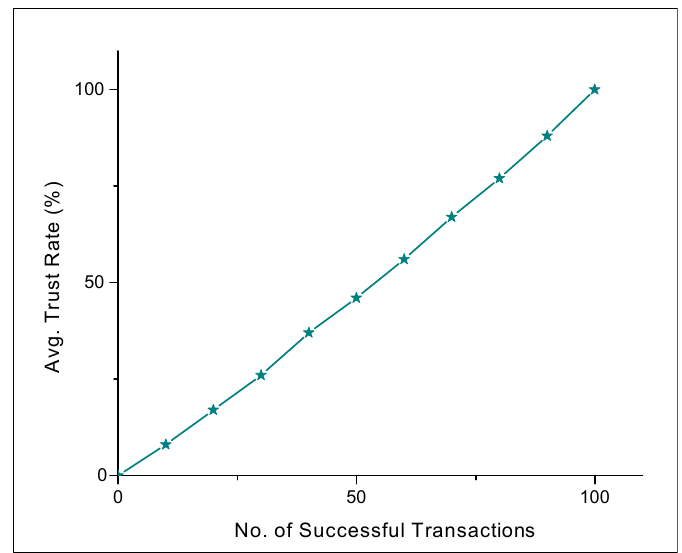
Figure 11. Trust Management between Ordinary and Edge Node Vehicles.